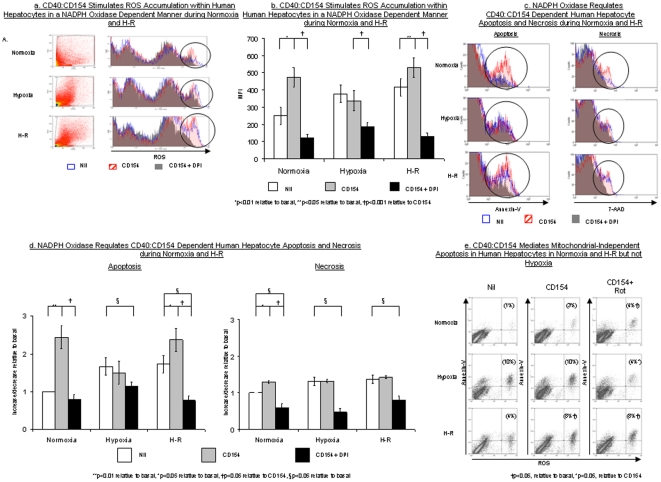
CD40∶CD154 regulates ROS accumulation, apoptosis and necrosis within human hepatocytes in a NADPH Oxidase dependent manner during normoxia and H-R.
Figure 2a demonstrates representative flow cytometry plots to illustrate the effect of CD154 (hatched red) and CD154 in presence of DPI (solid grey) upon human hepatocyte ROS accumulation during normoxia, hypoxia and H-R. Typical FS versus SS plots of primary human hepatocytes during normoxia, hypoxia and H-R are shown to the left of each flow cytometric plot. The FS versus SS plots shown is from the H-R alone sample of a liver preparation but similar plots were obtained during normoxia and hypoxia (data not shown). The areas of interest on the flow cytometric plots are marked by the vertical ellipses. The area on the left of each ellipse represents cell debris. Cell debris is included within the plot as human hepatocytes vary considerably in size and therefore to include all viable human hepatocytes in the analysis a large gate is required on the flow cytometer, this by necessity includes the cell debris. Figure 2b. shows a bar chart with the pooled data of three separate experiments illustrating the effects of CD154 and CD154+DPI upon human hepatocytes ROS accumulation. Data is expressed as MFI and readings are based upon values taken from cells within the gated region shown in Figure 2a. Data are expressed as mean ± S.E. (*p<0.01 relative to basal, **p<0.05 relative to basal, †p<0.001 relative to CD154). Figure 2c demonstrates representative flow cytometry plots to illustrate the effect of CD154 (hatched red) and CD154 in presence of DPI (solid grey) upon human hepatocyte apoptosis and necrosis during normoxia, hypoxia and H-R. Again, the area of interest within the flow cytometric plots is marked by the vertical ellipse. The same gate has been applied to primary human hepatocytes for these plots as those shown in Figure 2a. Figure 2d. shows a bar chart with the pooled data of three separate experiments illustrating the effects of CD154 and CD154+DPI upon human hepatocytes apoptosis and necrosis during normoxia, hypoxia and H-R. Data is expressed as increase/decrease relative to basal, where basal refers to the level of apoptosis or necrosis during normoxia alone. Data are expressed as mean ± S.E. (**p<0.01 relative to basal, *p<0.05 relative to basal, †p<0.05 relative to CD154, §p<0.05 relative to basal). Figure 2e. Human hepatocytes were treated with CD154 or CD154 following pre-treatment with rotenone (Rot) during normoxia, hypoxia and H-R. The percentage of cells staining with both the ROS probe DCF and apoptotic marker, Annexin-V, were assessed by flow cytometry. The percentage of human hepatocytes that stain for both DCF and Annexin-V are shown in parentheses. Data are representative of 3 separate experiments (†p<0.05 relative to basal, *p<0.05 relative to CD154).